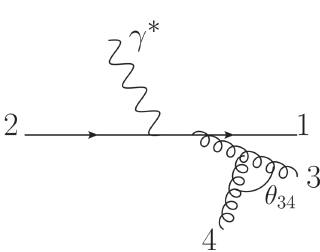
Figure 3 . One of the O ( α 2 ) γ ∗ → q ¯ qgg Feynman diagrams that contribute to the amplitude density s matrix A 4